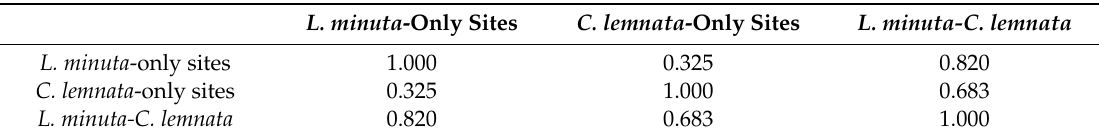
Table 2. Pairwise comparisons between site groups ( L. minuta -only sites, C. lemnata -only sites, L. minuta - C. lemnata sites) by the ANOSIM test. Probability values related to similarity between site groups are reported ( p < 0.05; significantly dissimilar groups).